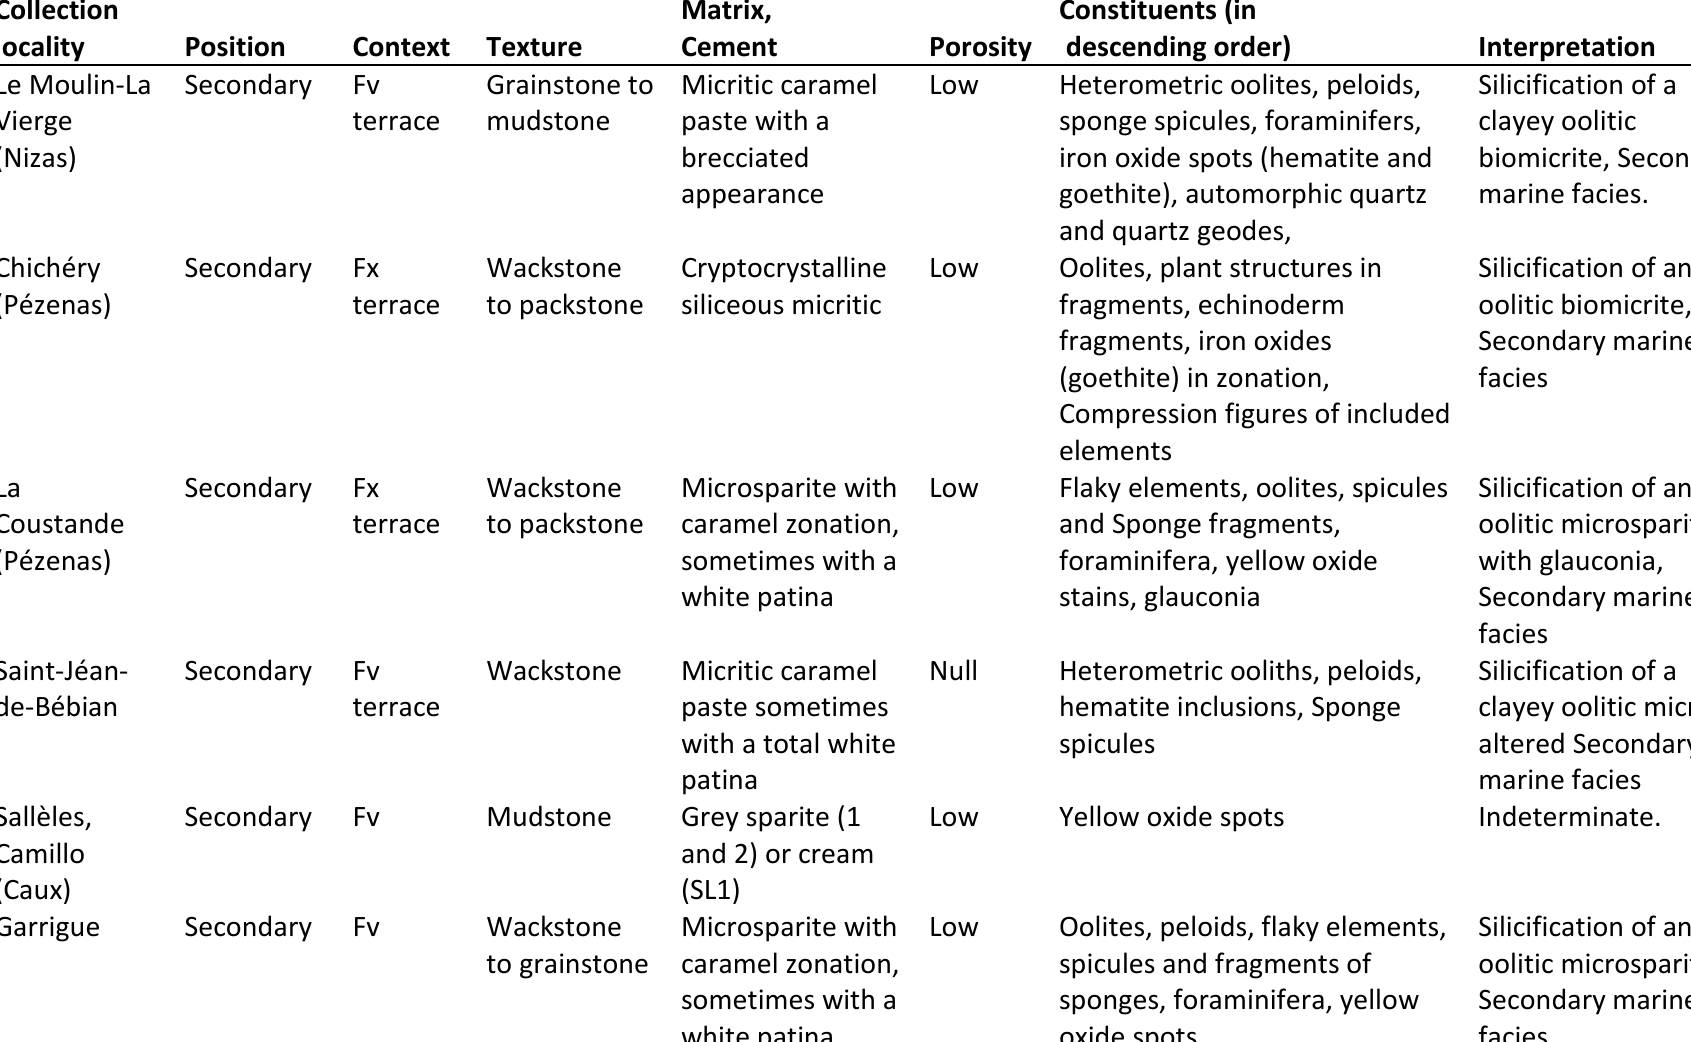
Table 2. Description of the flint facies from samples collected in the